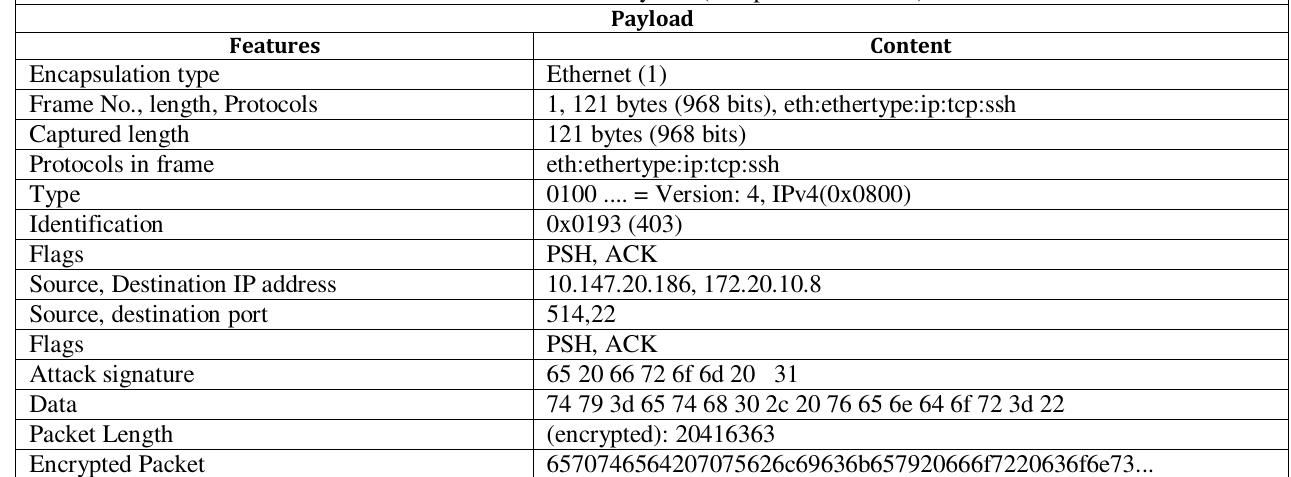
Table 1: Attack Packet Payload (Sample and